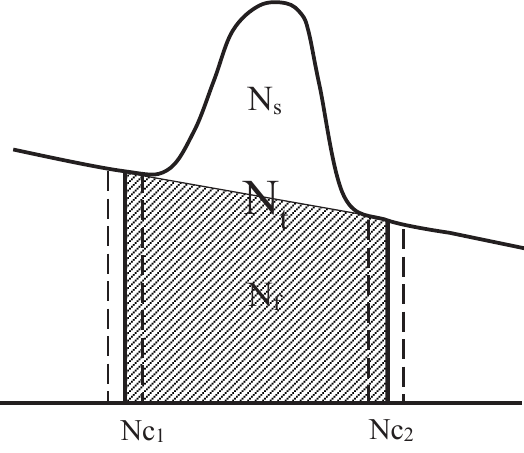
Fig.2. Graphic representation of the peak of the radionuclide in spectrum.